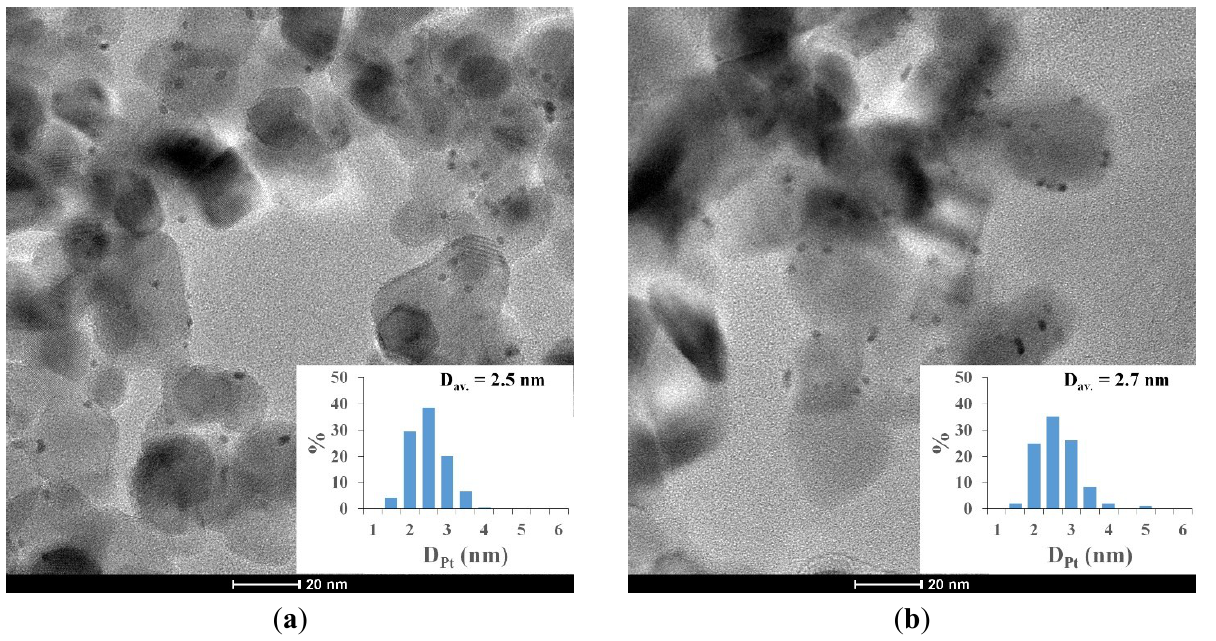
Figure 4. TEM images of Pt-TiO 2 (Pt was stabilized with 2.5 × 10 −4 M citrate during